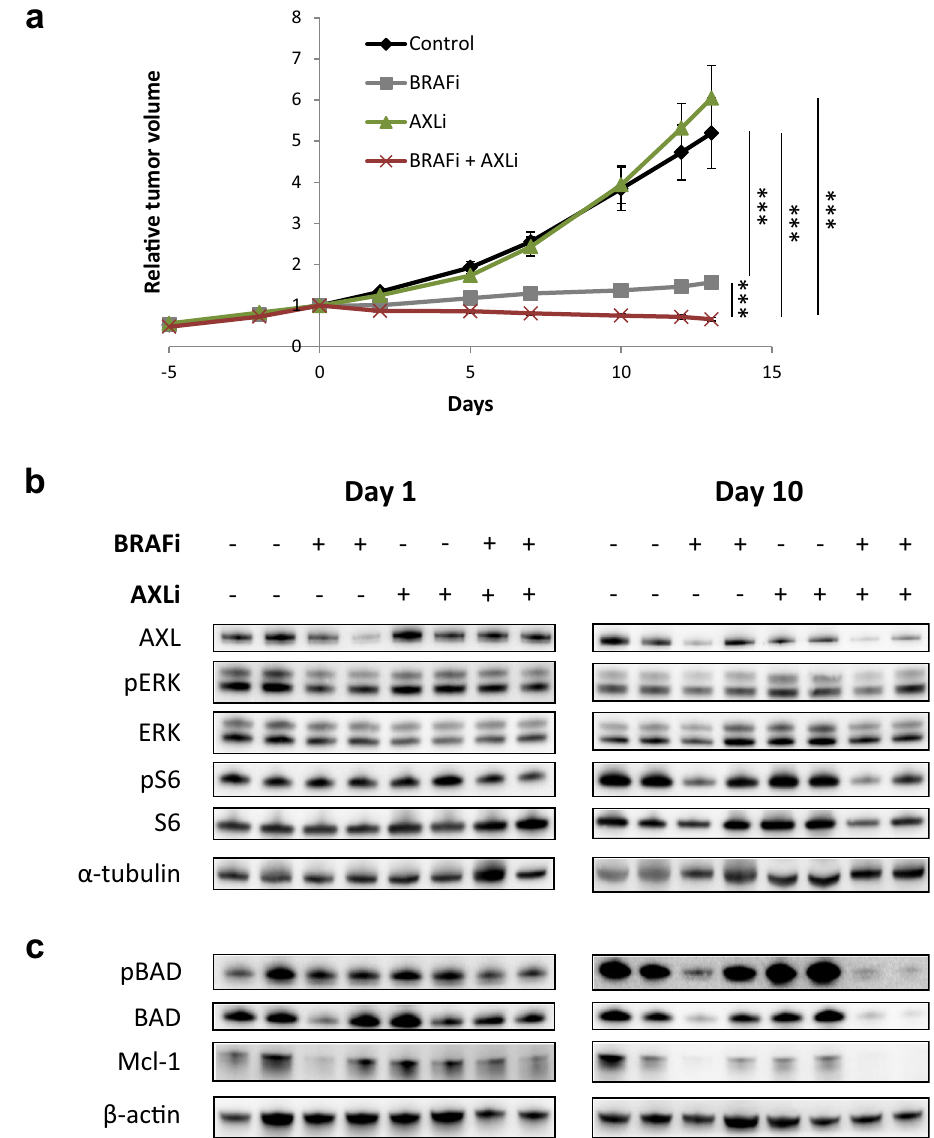
Figure 6. Melanoma cells in vivo show anti-tumor effect and apoptosis following combined inhibition of AXL and BRAF. Subcutaneous Melmet 1 tumors were treated with BRAFi (12.5 mg/kg), AXLi (50 mg/kg), the combination or vehicle (DMSO/methylcellulose) twice/day for 14 days. The tumor volume over time, presented as relative to the volume at treatment initiation ( a ) and the levels of indicated protein related to treatment efficacy ( b ) and apoptosis ( c ) in two tumors from each treatment group at day 1 and 10 are presented (cropped gels). ( a ) Average ± SEM, n = 8, *** p ≤